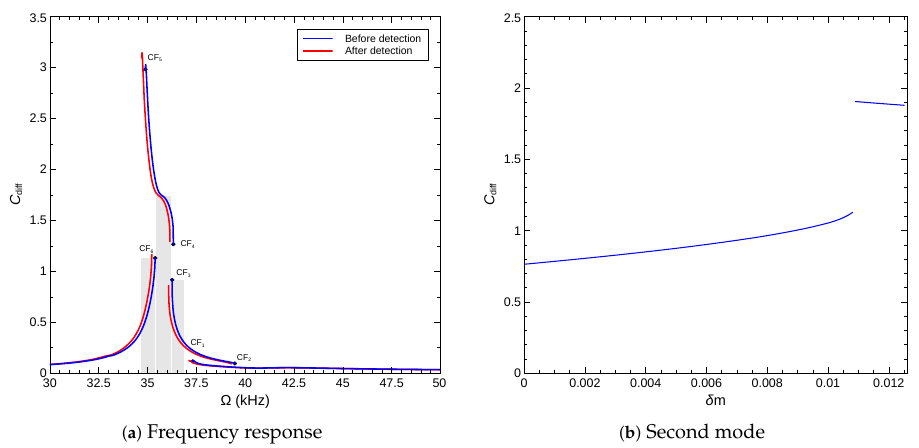
Figure 18. Differential capacitance detection mechanism: ( a ) the maximum normalized differential capacitance over the orbit for sensors made of an arch microbeam with an initial rise of w o = 6µm under the voltage waveform V DC = V AC = 12.2V, ( b ) the calibration curve of the bifurcation based sensor operating across CF 6 with an excitation frequency of Ω =